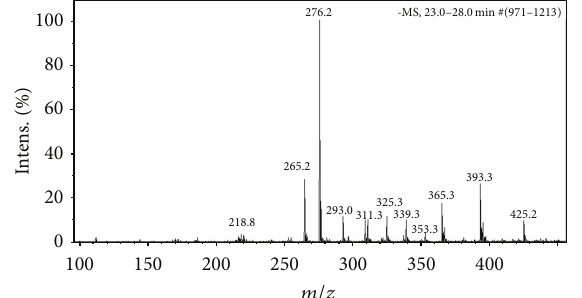
Figure 4: ESI-MS spectrum of the Naphthol AS-D pigment in the negative mode.